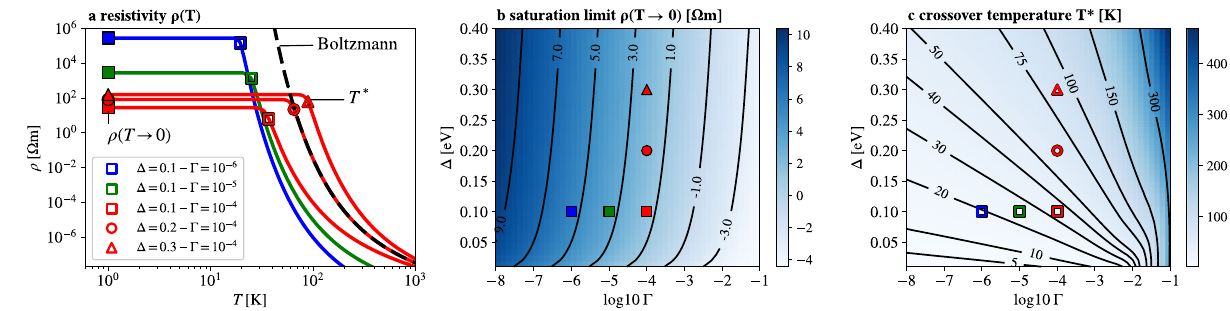
Fig. 4 Prototypical resistivity in correlated narrow-gap semiconductors. For a minimal two-band model, the fi gure shows: a The resistivity (lines) as a function of temperature for different gaps Δ and scattering rates Γ (both measured in eV). Closed symbols indicate the saturation limit ρ ( T → 0); open symbols mark the in fl ection point T * — the lower (upper) bound of the semi-classical (quantum) regime. The semi-classical Boltzmann conductivity, Eq. (2), is shown as a dashed black line. b The saturation limit ρ ( T → 0) (colored map; on a log-scale) as a function of Δ and Γ ; black lines are iso-curves for indicated values; colored symbols mark the choices of Δ and Γ from a . c Crossover temperature T * of the quantum regime. The data shows that T * ( ρ ( T → 0)) is dominantly controlled by Δ ( Γ ). Calculated for a three-dimensional half- fi lled two-band model with bare dispersions ϵ 0